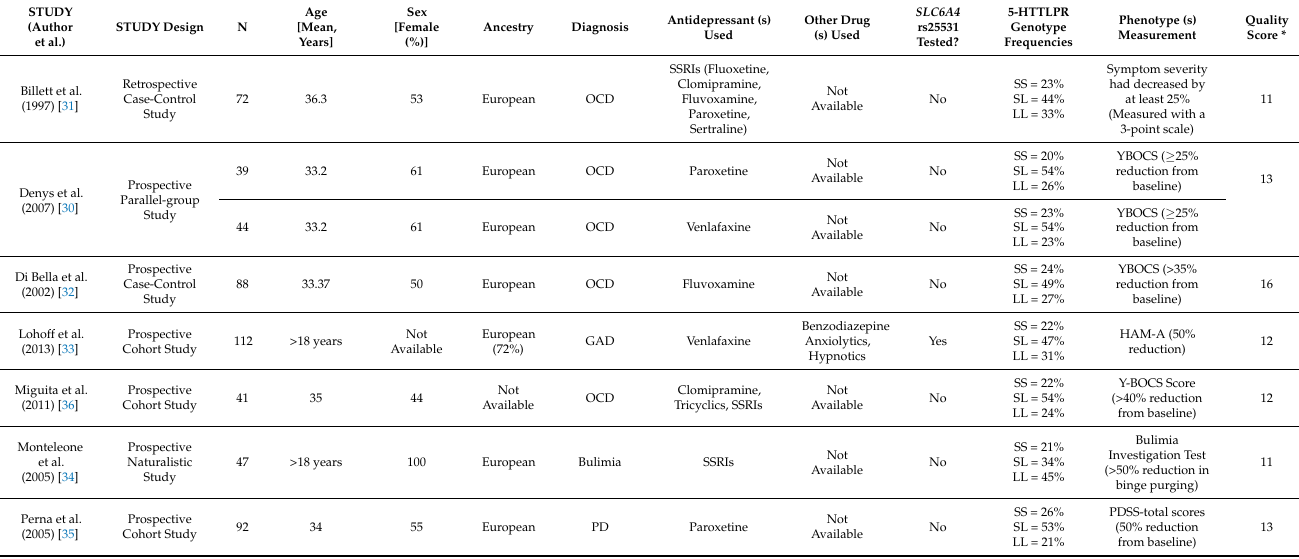
* The quality score ranges from 0–26 with higher scores representing higher quality. See Table S2 for detailed information on the specific quality metrics for each study. Abbreviations used: SS, two copies of the short allele; SL, short and long allele; LL, two copies of the long allele; GAD, generalized anxiety disorder; HAM-A, Hamilton rating scale for anxiety; MDD, major depressive disorder; OCD, obsessive compulsive disorder; PDSS, panic disorder severity scale; PD, panic disorder; YBOCS, yale–brown obsessive compulsive